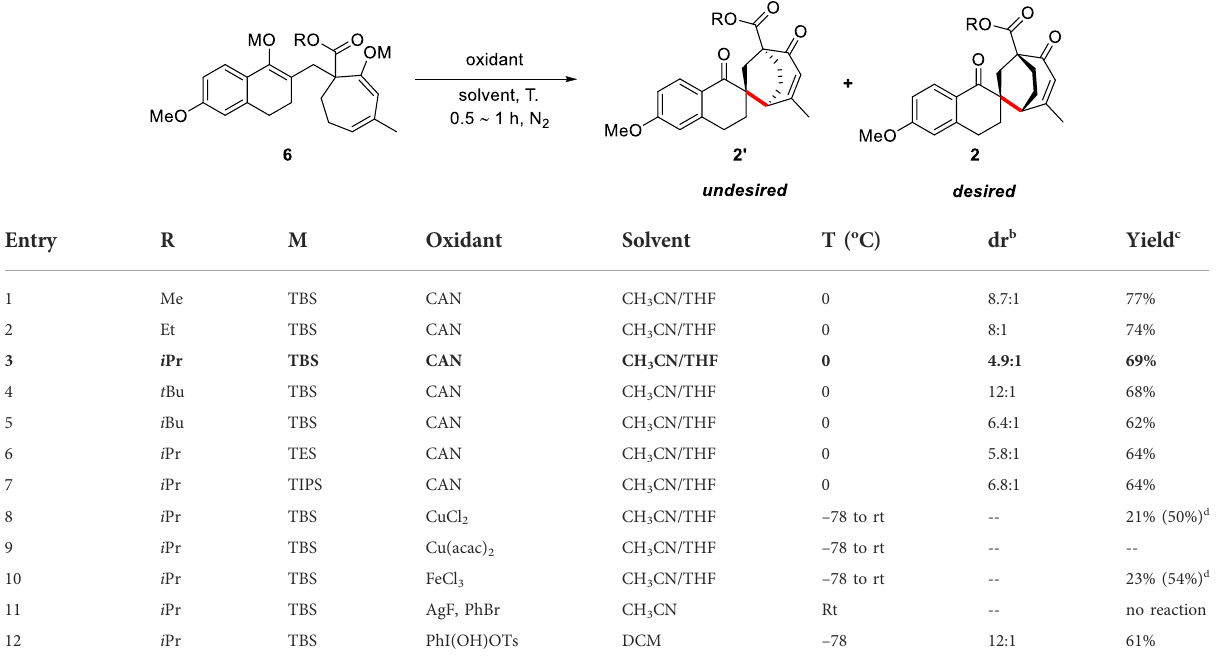
TABLE 3 Optimization of intramolecular EOC reaction conditions a